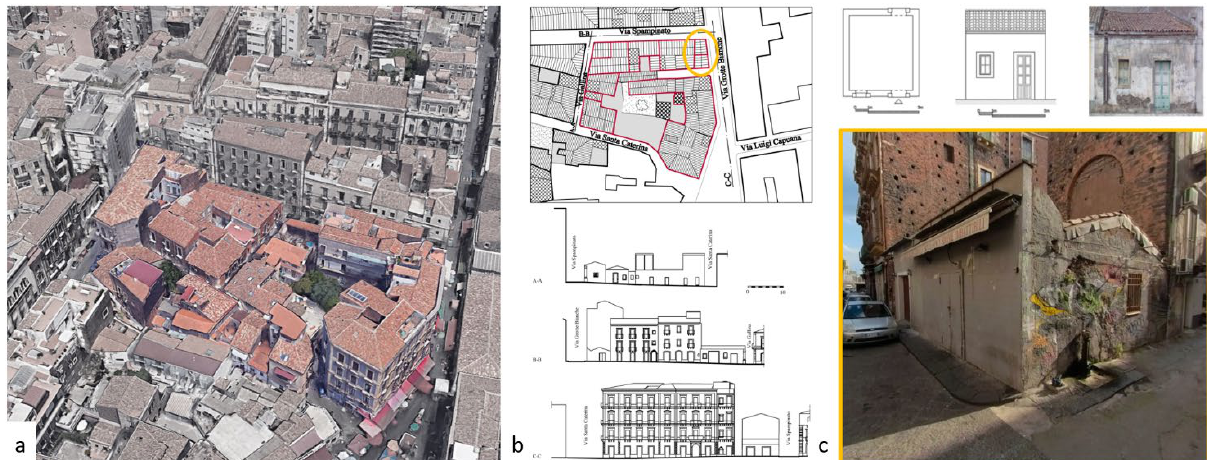
Figure 1 . View of the block under analysis (a). Planimetry and sections of the block. Highlighted in yellow the ground floor house (b). Archetype of the ground floor house typology and photo of the case study